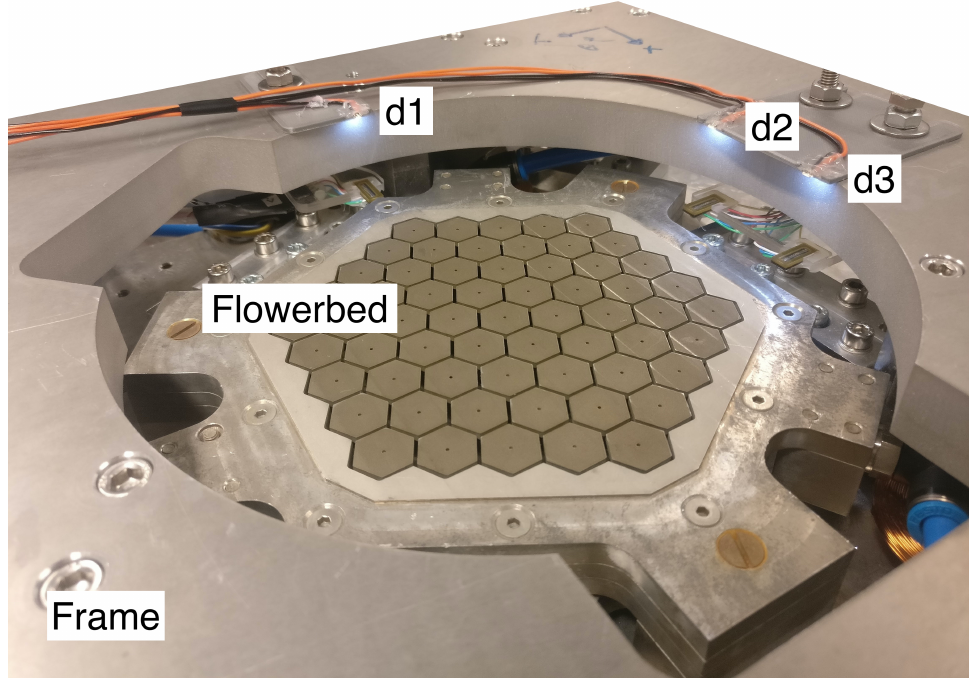
Figure 22. Photograph of the Flowerbed system with the implemented contactless sensing system without the wafer. The position of the sensors has been annotated according to Figure 21, and for reference, the diameter for the inscribed circle in each of the 61 hexagonal flowers is